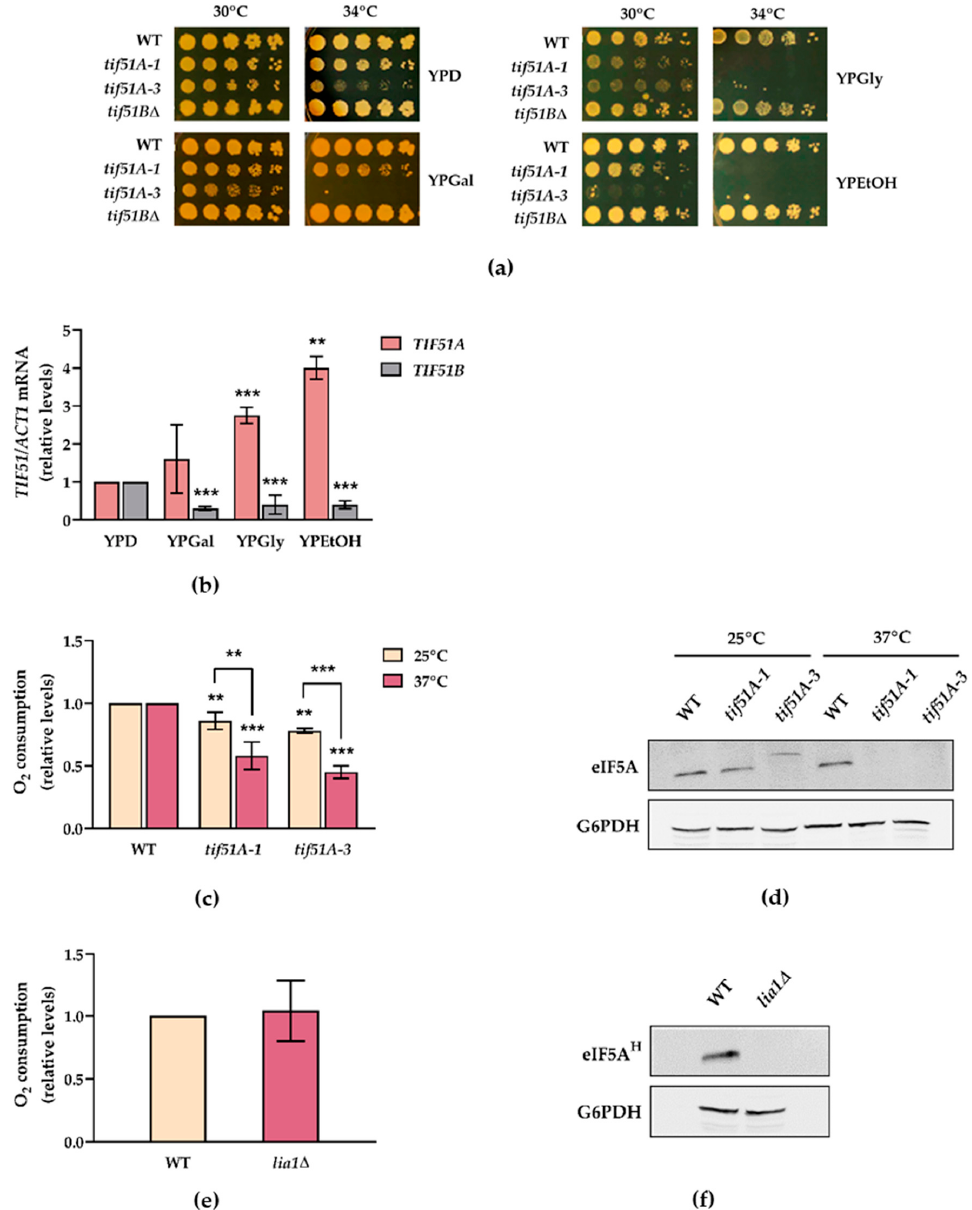
Figure 1. TIF51A is required for respiration independently of hypusination. ( a ) Growth of the WT, tif51A-1 , tif51A-3 and tif51B ∆ strains was tested in YEP medium containing 2% glucose (YPD), 2% galactose (YPGal), 2% glycerol (YPGly) or 2% ethanol (YPEtOH) at the indicated temperatures. ( b ) The WT cells were grown in YPD, YPGal, YPGly or YPEtOH to the exponential phase (OD 600 of 0.5). Relative TIF51A and TIF51B mRNA levels were determined. ( c ) The WT, tif51A-1 and tif51A-3 strains were grown in YPGal at permissive temperature (25 °C) and transferred to non-permissive temperature (37 °C) for 4 h until an OD 600 of 1.5–2 was reached. Relative oxygen consumption rates are shown. ( d ) Western blotting of eIF5A in the WT, tif51A-1 and tif51A-3 cells at 25 °C and 37 °C showing eIF5A depletion. Glucose-6-phosphate dehydro- genase (G6PDH) protein levels were used as loading controls. tif51A-3 mutated protein migrates slightly more slowly than the wild-type Tif51A and tif51A-1 mutant due to the mutation of glycine 118 to aspartic. ( e ) The WT and lia1 ∆ strains were grown in YPGal at 30 °C until an OD 600 of 1.5–2 was reached. Relative oxygen consumption rates are shown. ( f ) Western blotting of hypusinated eIF5A in the WT and lia1 ∆ showing differences in hypusination. G6PDH protein levels were used as the loading controls. ( b , c , e ) The results are shown as the means ± SD of three independent experiments and expressed in relation to the value for the 2% glucose condition or the WT. Statistical significance was measured by a Student’s t -test in relation to the 2% glucose condition or WT. ** p < 0.01, *** p <